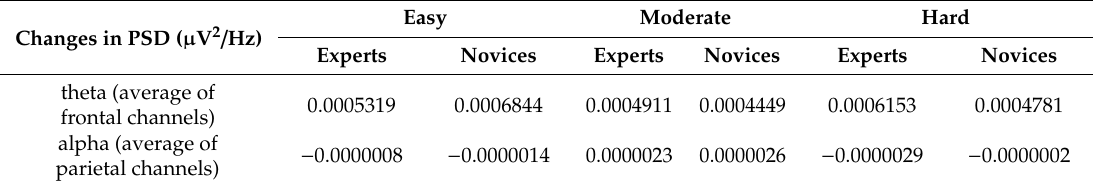
Table 2. Changes in PSD of theta and alpha averaged for all tasks.